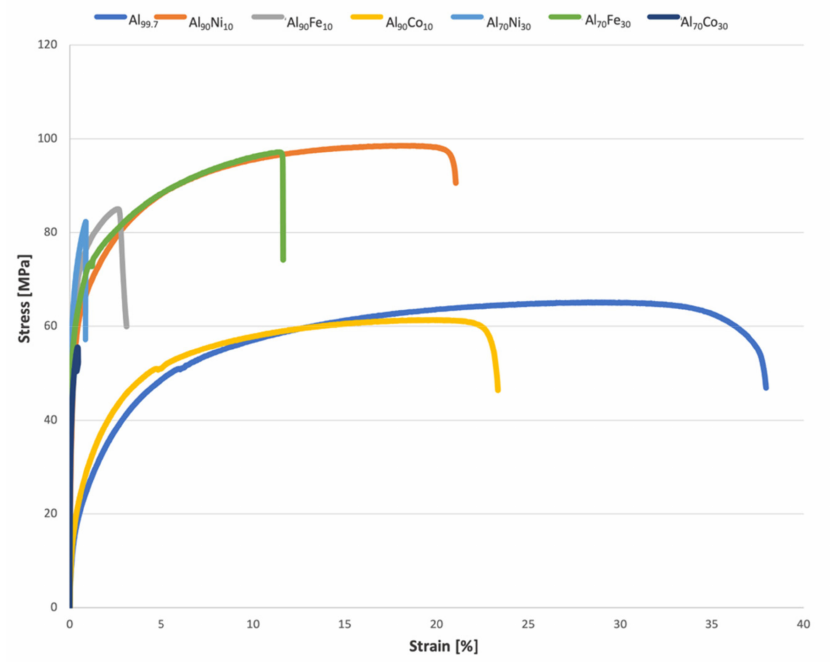
Figure 9. Stress-strain diagram of Al and Al with different percentages of ferromagnetic particles Fe, Ni, and Co.